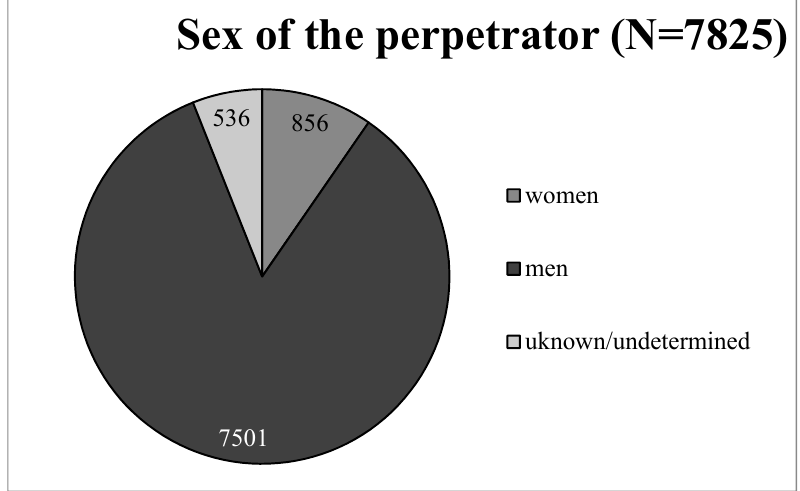
Figure 4. The distribution of perpetrators by sex.